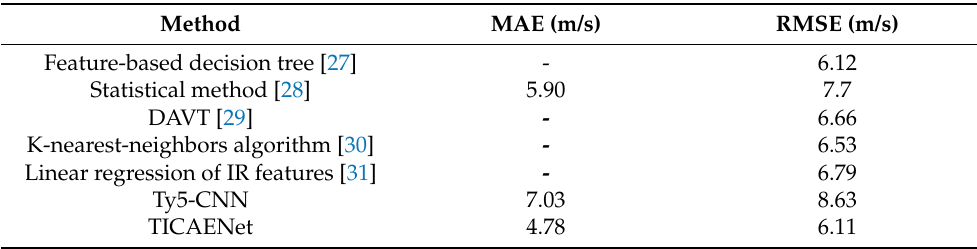
Table 9. Comparison of intensity estimates among various